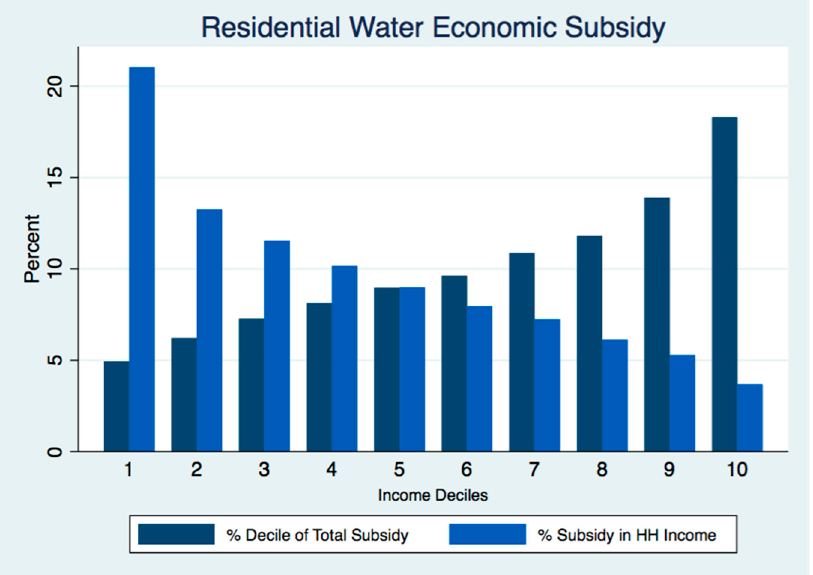
Figure 11. Residential water subsidies, 2014. Source: Own calculations with data from ENIGH [25]; and PIGOO [27].